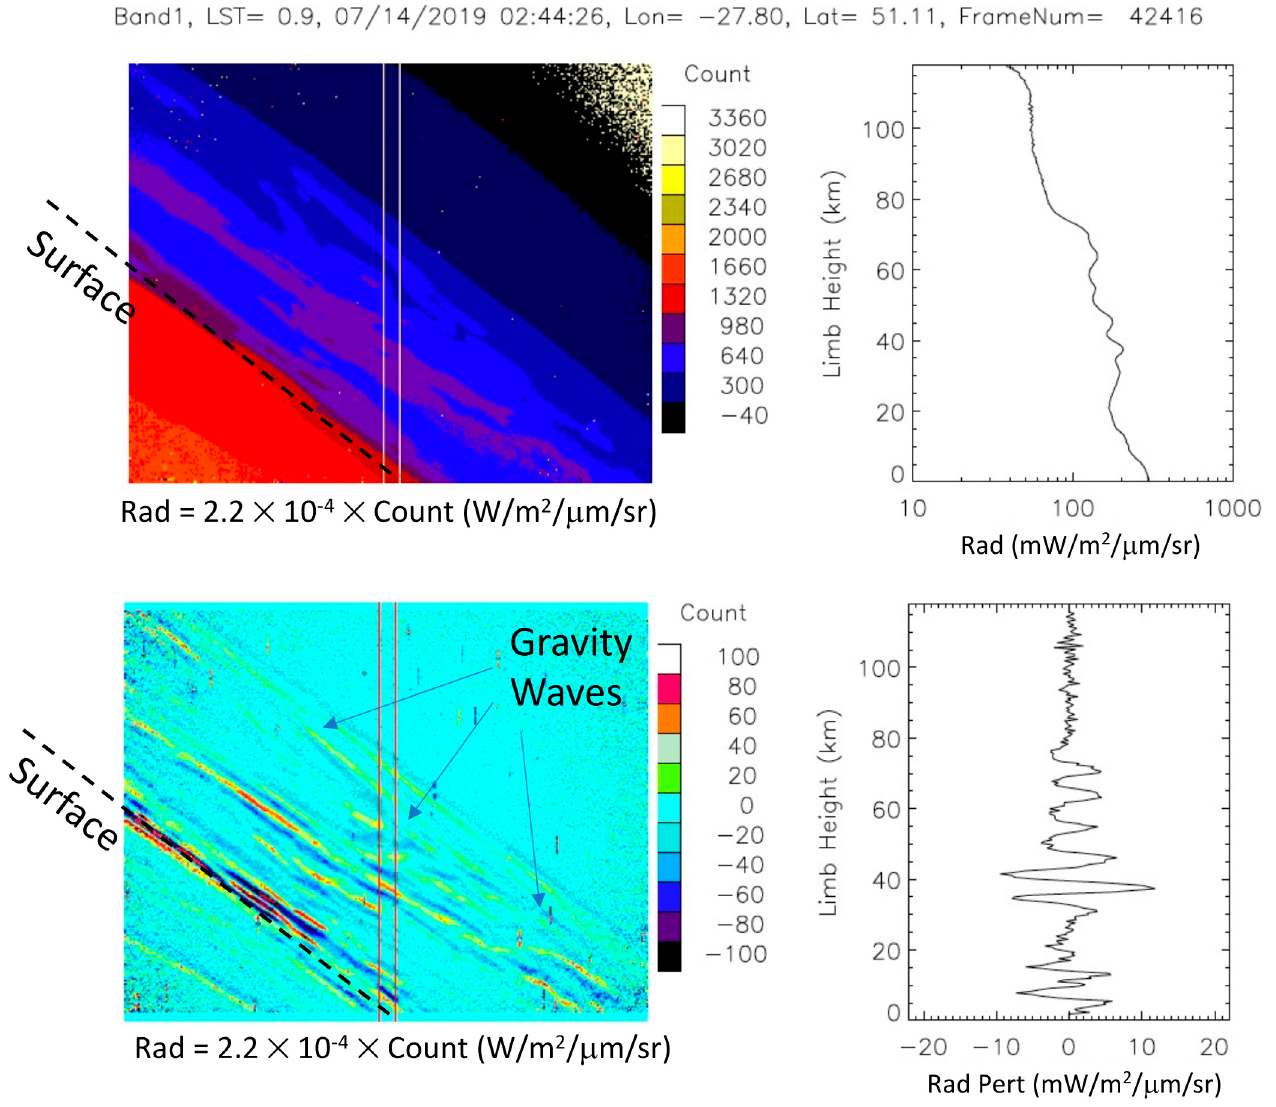
Figure 4. Nighttime (LST = 0.9 h) CTI image from the ISS pitch-down on 14 July 2019: band1 limb radiances ( top panels) and band1 radiance perturbations ( bottom panels). The perturbations were computed from the difference between the raw and a 11-pixel running mean in the row measurements. Note that the limb height was not the tangent height, but it could be used to estimate tangent height by subtracting the estimated surface height (the dashed line in the image). The limb surface was estimated using the modeled radiance value from Figure 2.